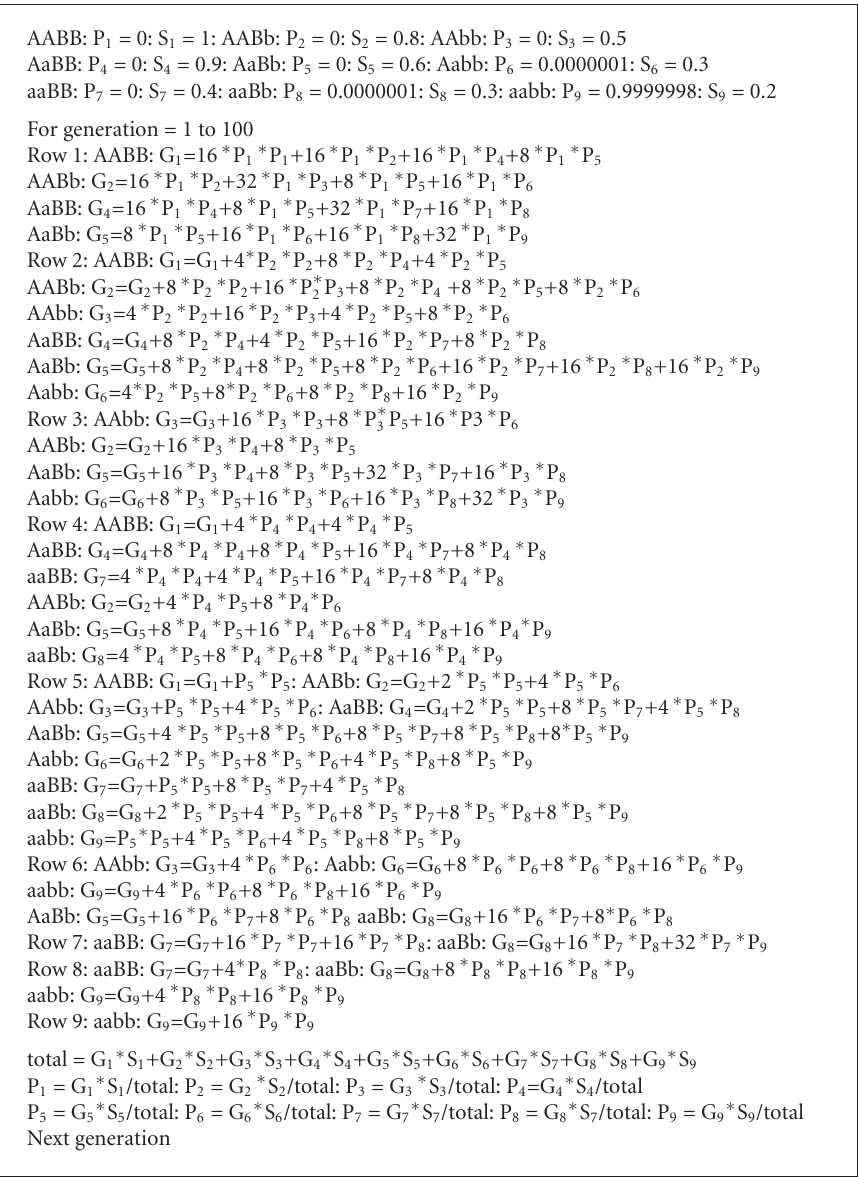
Algorithm 1: General code for algorithms to calculate the proportions P 1 to P 9 of the nine mated genotypes (AABB to aabb, see Table 1) for 200 generations based on initial proportions and nine constant survival factors S 1 to S 9 for individuals of these genotypes (an asterisk denotes